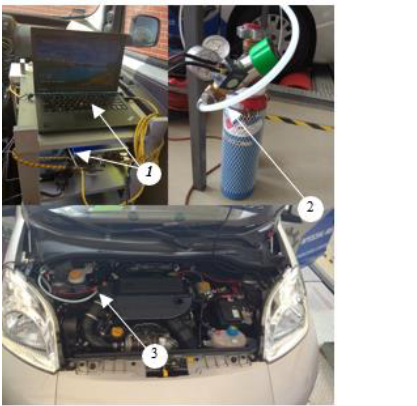
Fig. 2. Research site: 1. The view inside the vehicle with research appa- ratus: computer with AVL software, measuring module AVL and AVL converter, 2. Hydrogen cylinder, 3. The view of the engine compartment with the hydrogen supply location